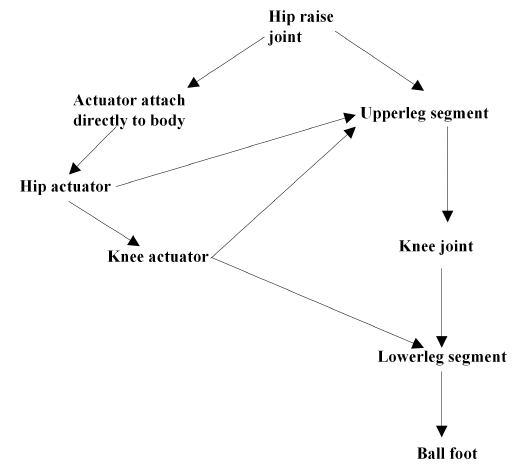
Fig. 2 ‘Humanoid Robotics” Ontology O 2 .